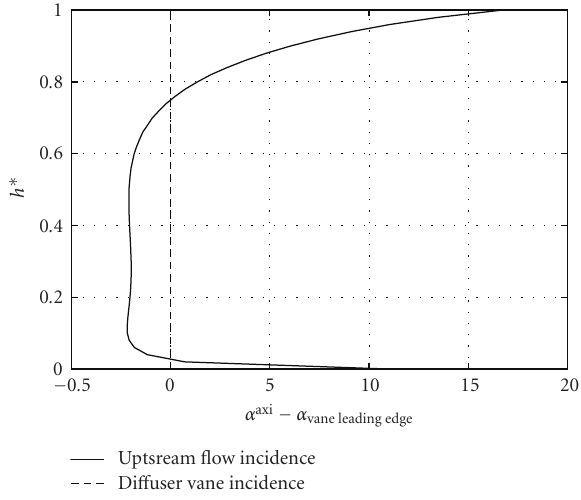
Figure 18: Evolution of the axisymetric Incidence at di ff user inlet from